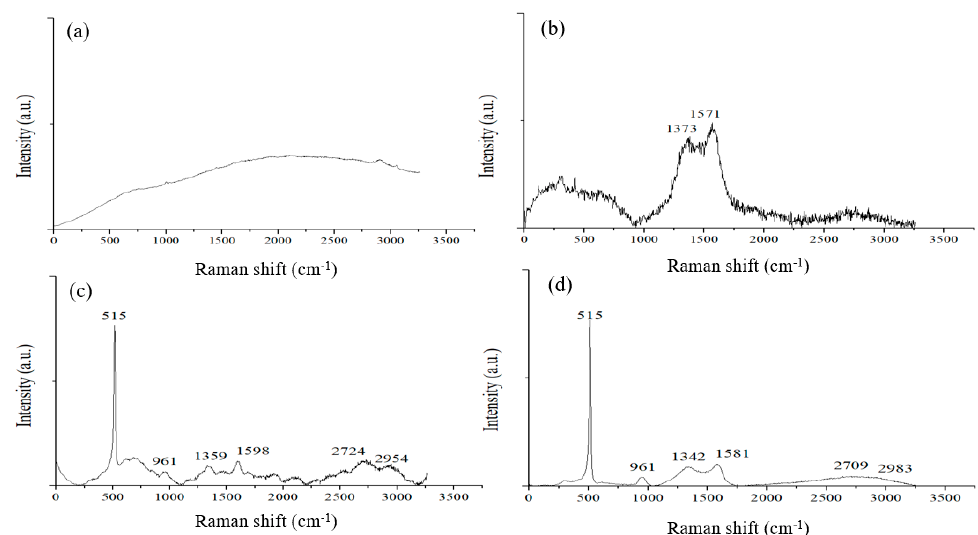
Figure 6. Raman spectra excited by 532 nm laser measured from ( a ) CMC/SBR film; ( b ) Pyrolytic CMC/SBR film; ( c ) Electrode made of silicon flakes and CMC/SBR binder of a weight ratio of 70%:30%; and ( d ) the electrode in ( c ) after pyrolysis.